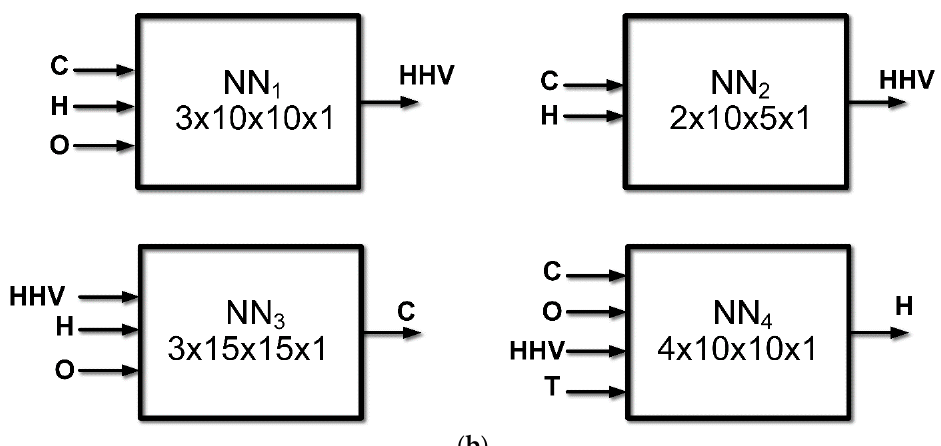
M , M , M , 1 2 3 M , M , M , and M . 1 2 3 4